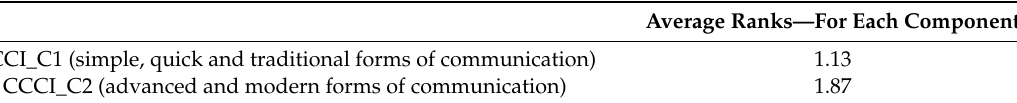
Table 23. Average ranks—for two components of CCCI. Average Ranks—For Each